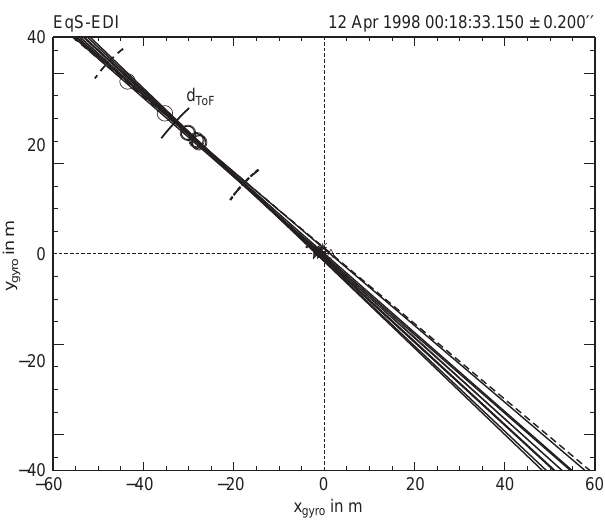
Fig. 6. A second comparison of triangulation and time-of-flight results for a 0.4-s interval near 00:18:33 UT on the same day. The format is the same as that of Fig. 5, except for a scale change. Triangulation ( circular symbols ) implies a drift step of 35–55 m, in fair agreement with the (43 : 5 (cid:6) 20)m calculated from the di(cid:128)erence between the times-of-flight. The magnetic field was only 35 nT in this case, and so the measured drift step corresponds to a drift velocity of 42 km s (cid:255) 1 , equivalent to an electric field of 1.5 mV m (cid:255)